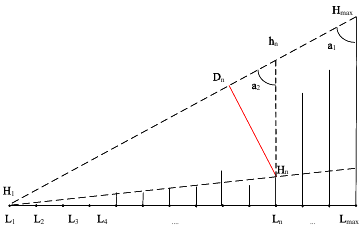
Figure 3. Schematic illustration of triangular threshold. , ,..., L L L are the different grey levels, and Suppose that 1 2 max , ,..., H H H represent their corresponding frequencies. As max h is the intersection point between shown in Figure 3, n H H and the extension line h L of a is the angle L H , 1 max n n 1 n n H H and a is the angle between L H , between 1 max max max 2 H H and the extension line D H is the h L of L H , and 1 max n n n n n n H H . H to line perpendicular distance from point n 1 max